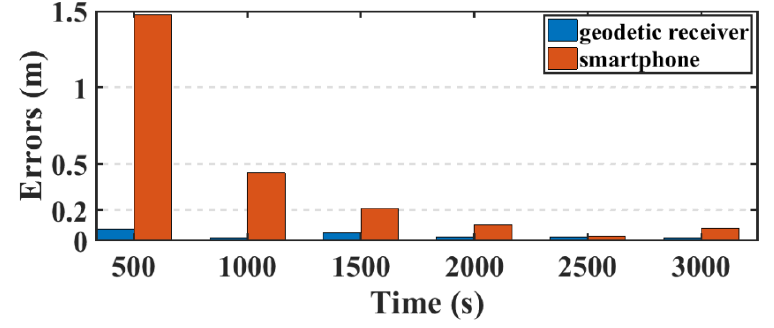
Figure 14. Position errors in East direction (meters).